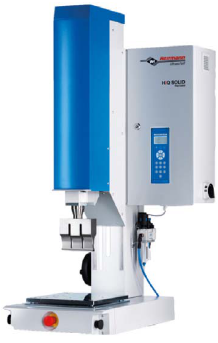
Figure 4. Directivity pattern at 20 kHz of a GRAS 40BF microphone cartridge. The angle-dependent sensitivity is nor- malized to the maximum. The coordinates are normalized to the distance r between the loudspeaker and the microphone. polar angles in the interval of 0 (cid:3) to 30 (cid:3) and 5 cm for polar angles in the interval of 32 (cid:3) to 115 (cid:3) . As an example, the